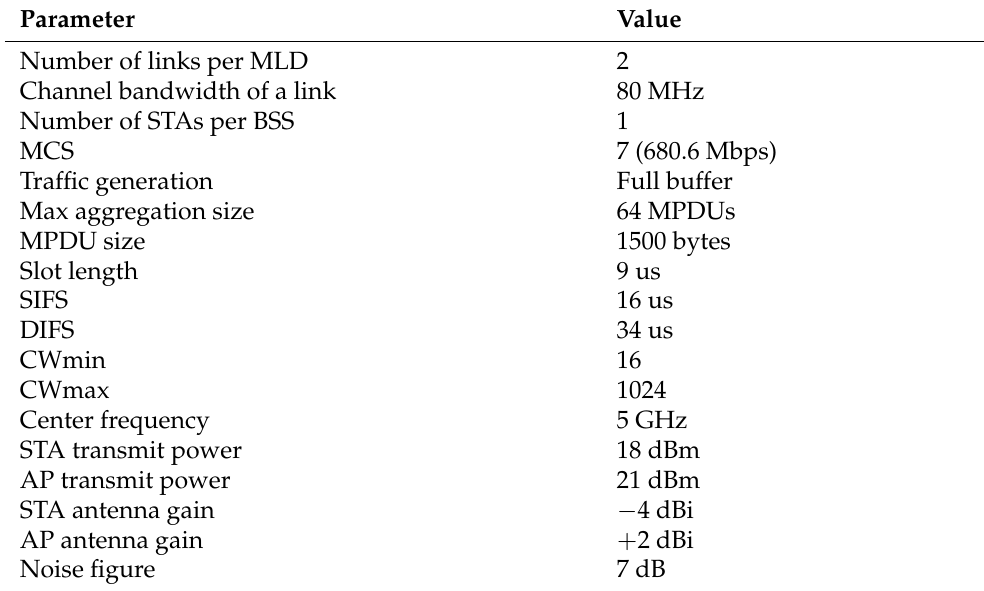
Table 1. Simulation